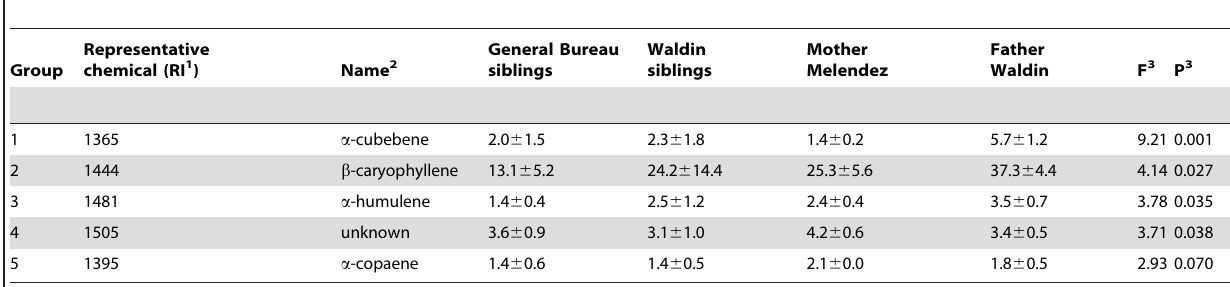
Table 3. Average composition (%) of the representative compounds of each group of chemicals selected by the stepwise discriminant